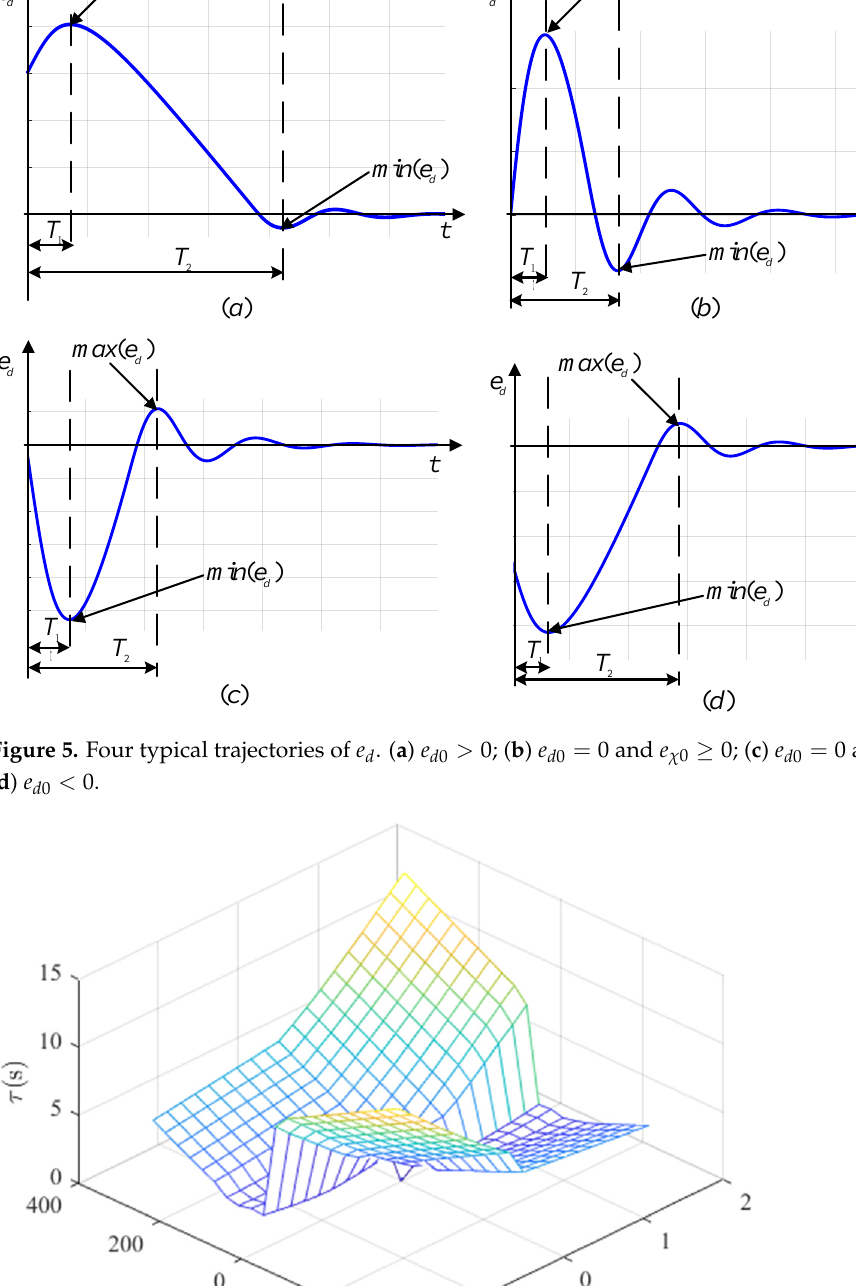
and 𝑒 . (cid:3031)(cid:2868) (cid:3102)(cid:2868)